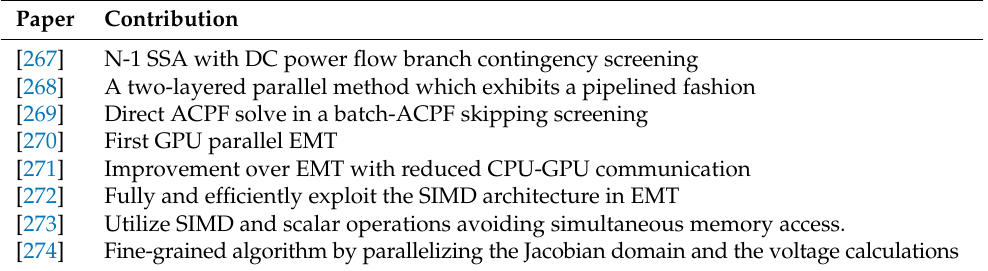
Table 7. Power System Stability SIMD-based state-of-the-art studies.